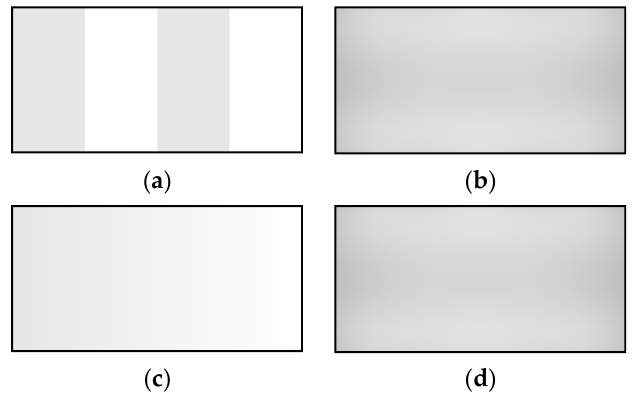
Figure 8. High SPS sat vs. Low SPS sat . ( a ) High SPS sat original image; ( b ) High SPS sat image after excessive dimming; ( c )Low SPS sat original image; ( d )Low SPS sat image after excessive dimming.